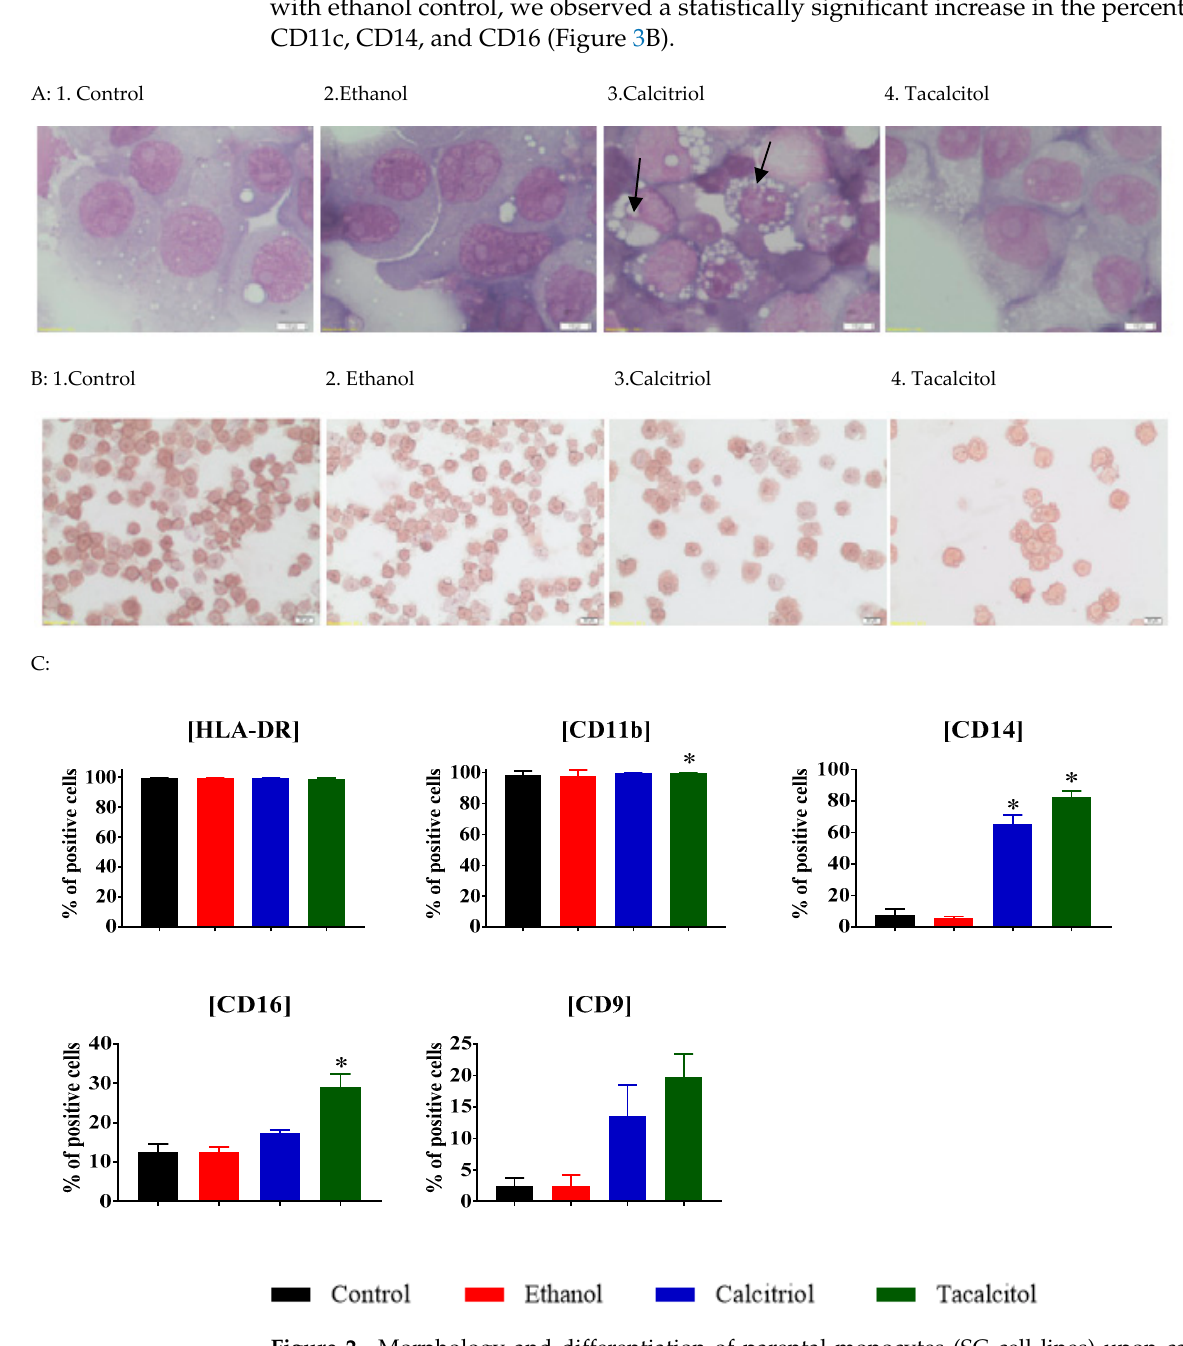
Figure 2. Morphology and differentiation of parental monocytes (SC cell lines) upon calcitriol and tacalcitol treatment: ( A ) May–Grunwald–Giemsa staining scale bar 10 µ m. Each staining was performed independently twice; Black arrows indicate the vacuolization inside the cells. ( B ) immunocytochemical HLA-DR staining scale bar 20 µ m. Each staining was performed independently twice; ( C ) distribution of differentiation markers by flow cytometry analysis. Mean values and standard deviation are presented. Statistical analysis: Sidak’s multiple comparisons test; significant differences as compared with ethanol (* p < 0.005). The graphs represent data from at least three separate experiments. Blank arrow indicate the vacuolization inside the cells.